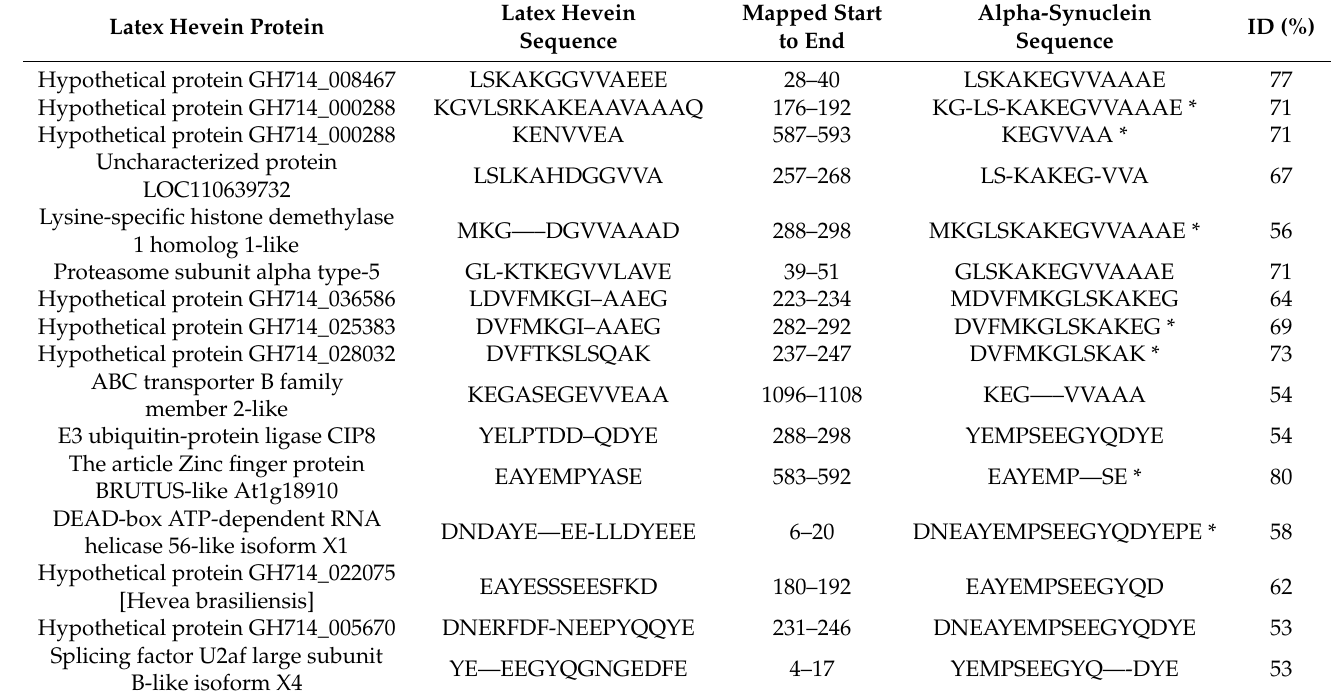
Table 3. Potential cross-reactive epitopes between alpha-synuclein proteins and latex hevein proteins.